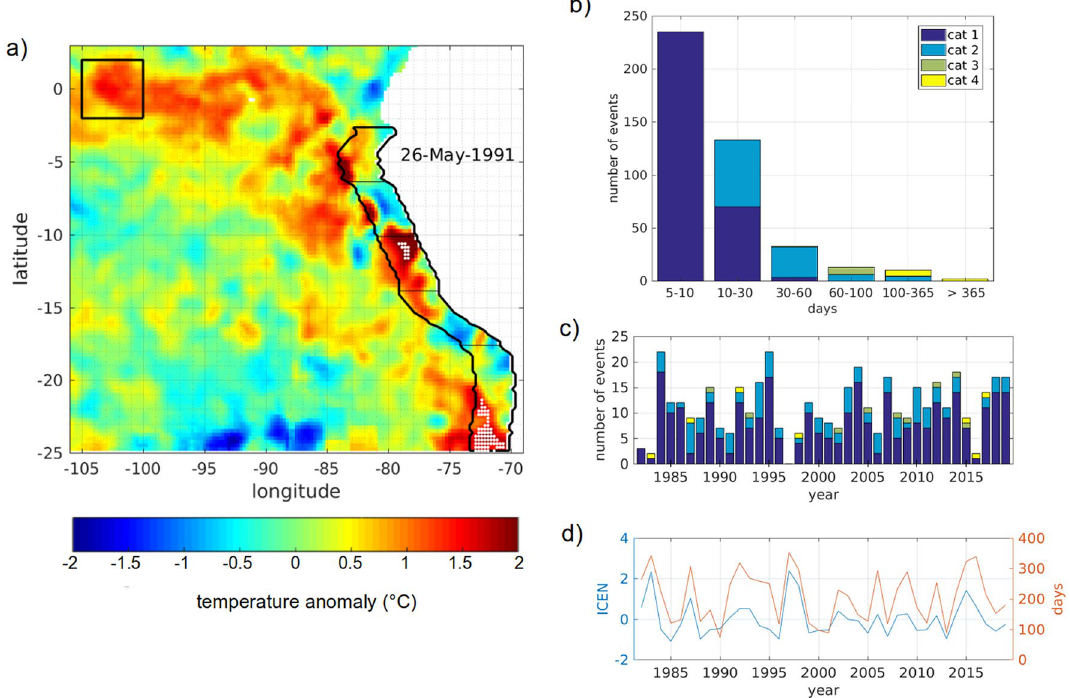
Figure 1. ( a ) SST anomaly in the South Eastern Pacific on 26 May 1991. The coastal domain considered in the study is circled in black. The black box represents the equatorial region used to detect remote occurrences of MHWs. White dots indicate data point where the criterium for MHW detection is met. Agglomerations of white ◦ S ◦ S dots at ∼ 11 and ∼ 23 correspond to two spatially coherent MHW events. Histograms on the right side show the distribution of MHWs in the coastal region. ( b ) Number of MHWs sorted by duration and category. ( c ) Number of events each year, colors indicate the category in which they are. When an event spans over 2 years it is allocated to the year where the maximum SST anomaly falls. ( d ) ICEN values averaged yearly (blue) and number of days affected yearly by MHWs in the coastal domain (orange). The figure was created using Matlab R2020b (https:// matlab. mathw orks. com/).